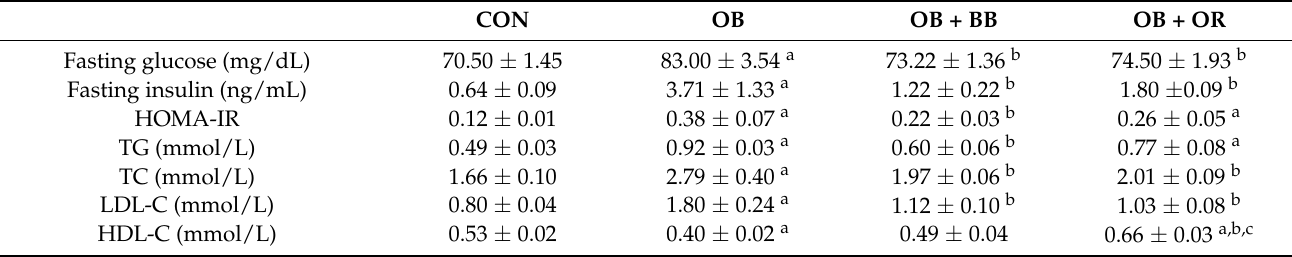
Table 4. Serum fasting glucose, insulin resistance and lipid profile of rats in the experimental groups. CON OB OB + BB OB + OR Fasting glucose (mg/dL) 70.50 ±